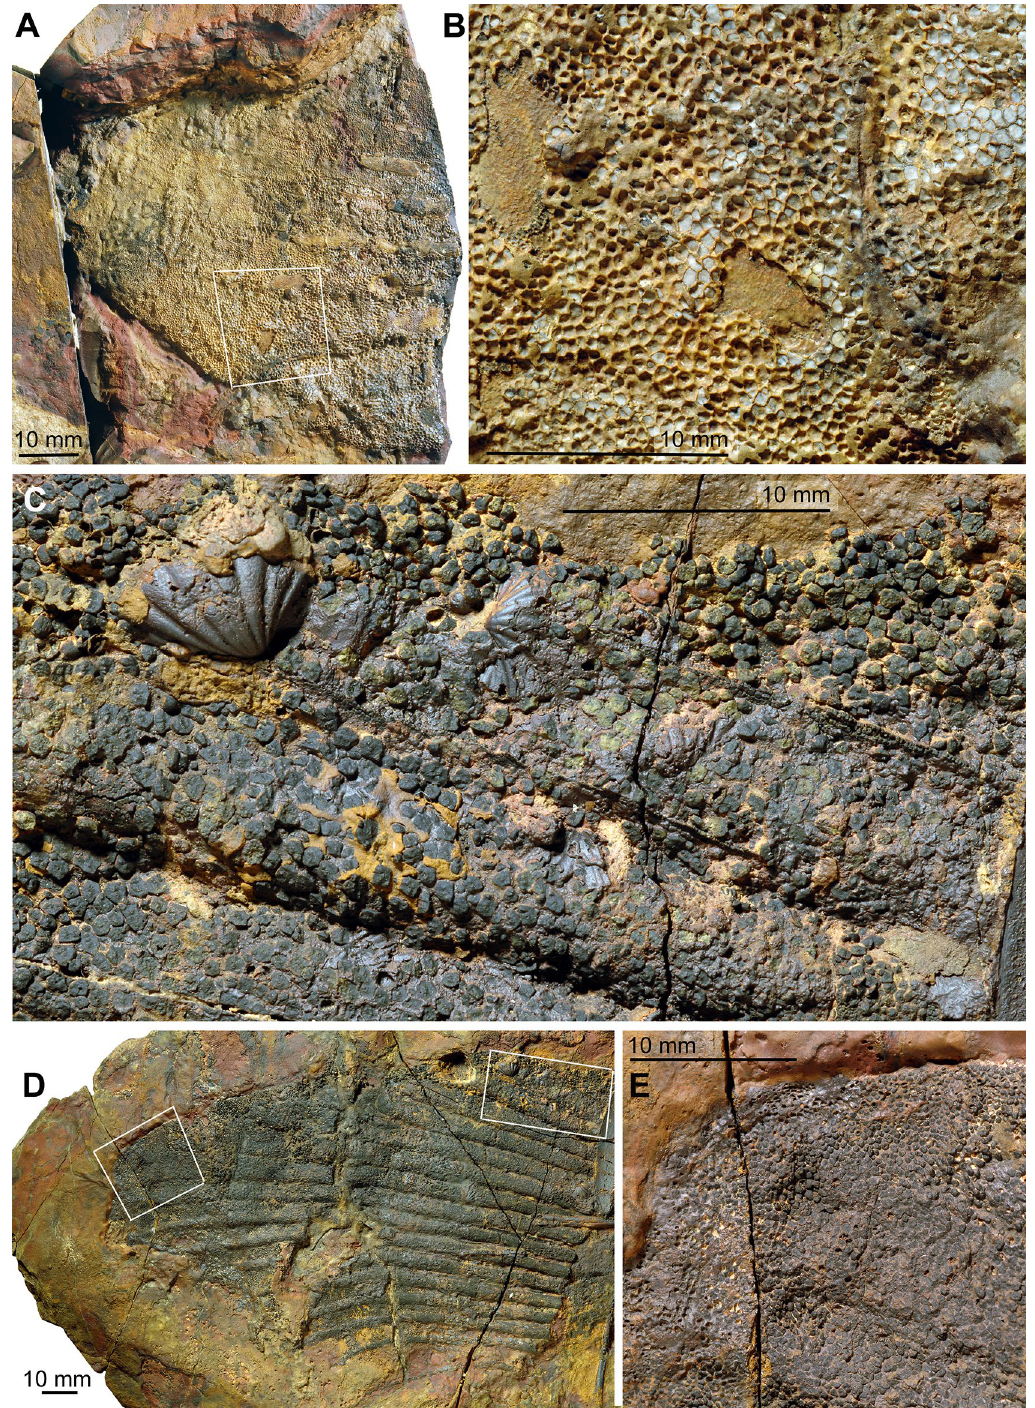
Fig. 9 Details of the pectoral fins of Maghriboselache mohamezanei n. gen. et sp., PIMUZ A/I 5154. A tip of the left fin with articulated, though weathered integument, showing the localization of figure B. B detail of the fin with dermal denticles. C detail of the right pectoral fin showing the dermal denticles overlying the radials. D overview over the right fin, showing the localization of figure C and E. E detail showing the integument at the distal tip of the fin. Note the reduced denticle